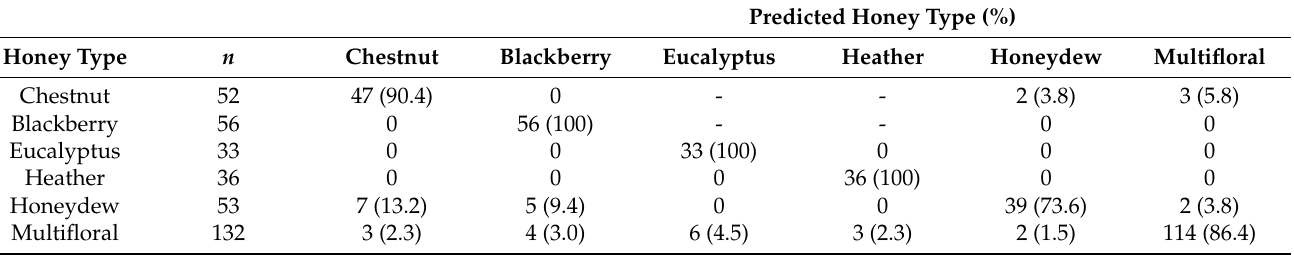
Table 4. Results of the statistics according to LDA. DF: degrees of freedom. Table 5. Number of samples and correct percentage of classification (in brackets) by honey type according to the